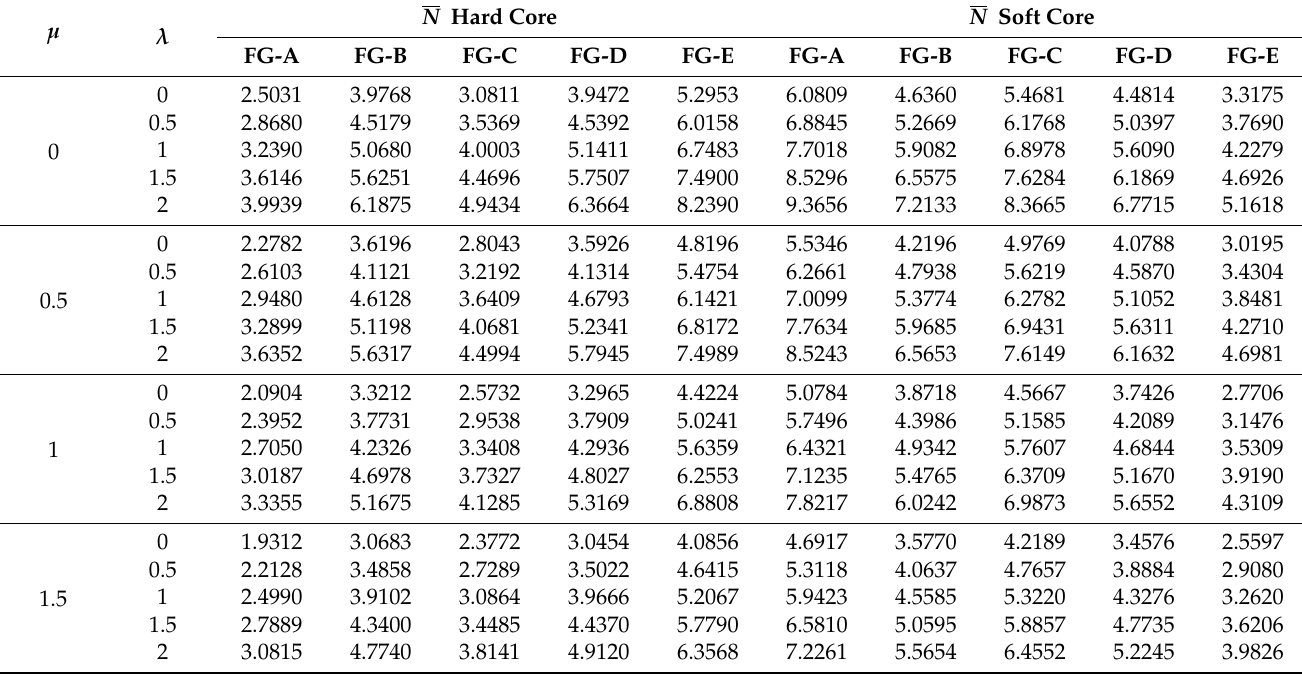
Table 7. Dimensionless critical buckling load N of FG nanoshells versus nonlocal and